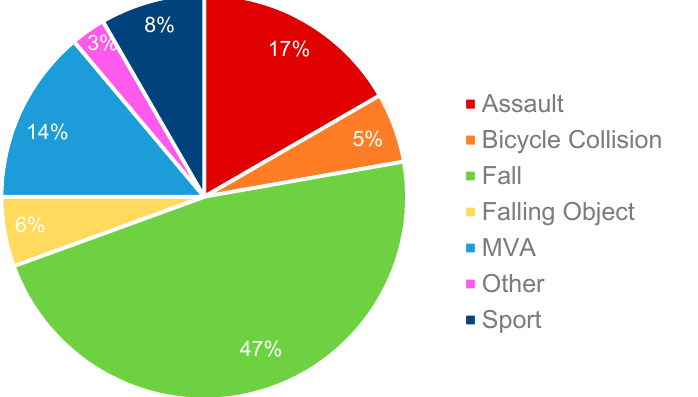
Figure 2. Breakdown of mTBI by type of causal mechanism ( n = 36).